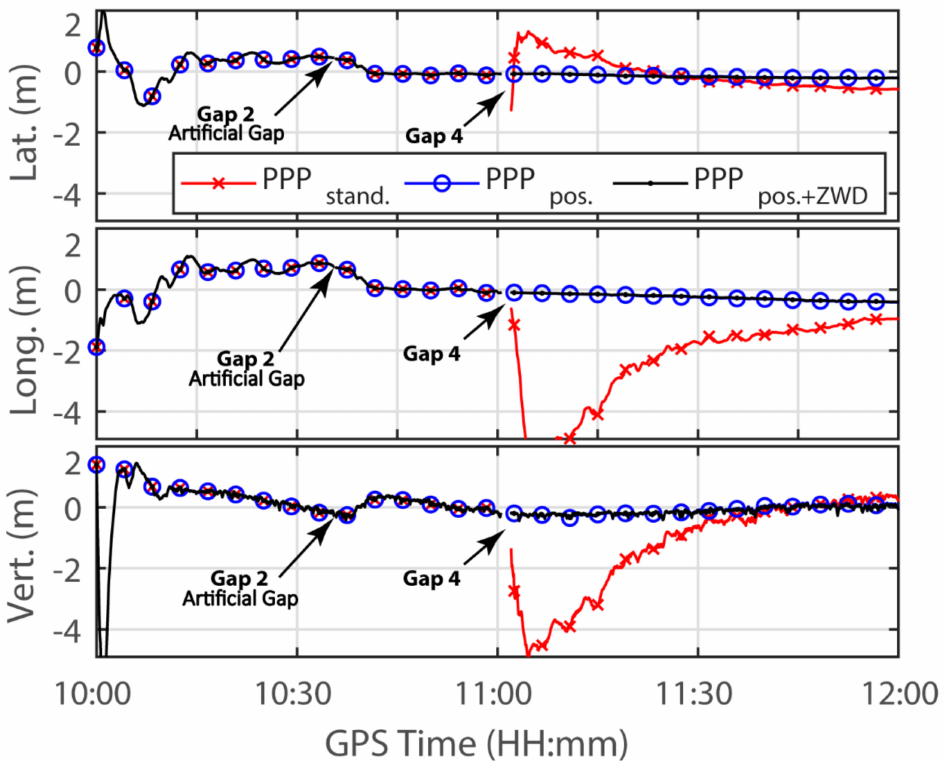
Figure 5. Standard PPP and constrained PPP time series at bridge surveying point B over 2 h for the latitudinal, longitudinal and vertical